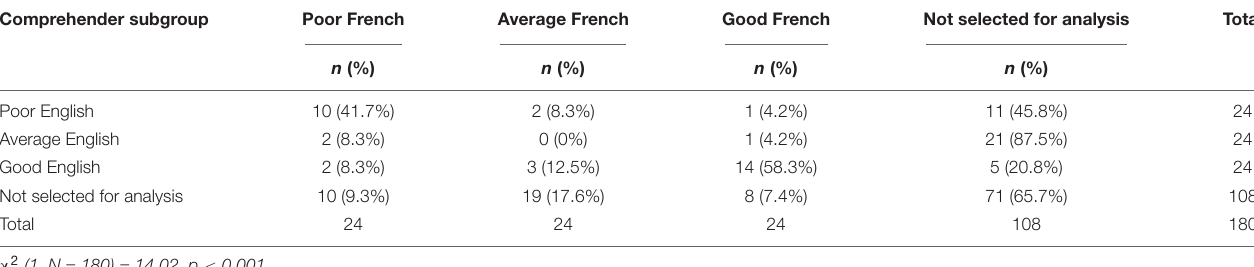
TABLE 4 | The overlap and distribution of poor reading comprehension in English and French.